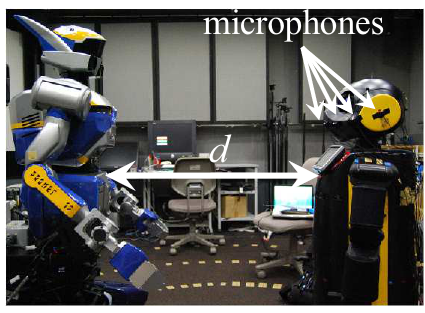
Figure 10. HRP-2withitsstereoloud- speakers marked by rect- angles